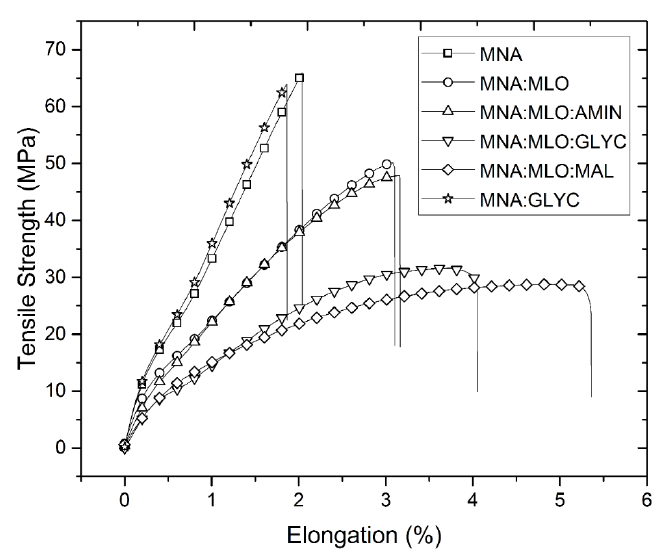
Figure 4. Plot representation of tensile strength (MPa) vs. Elongation. Polymers 2019 , 11 , x FOR PEER REVIEW